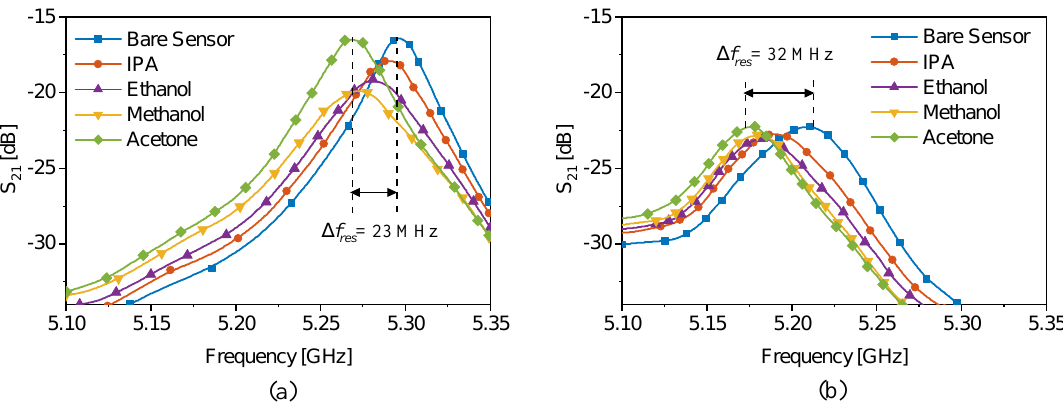
Figure 16. Measured transmission response for both sensors using ( a ) external channel and ( b ) embedded channel filled with IPA, ethanol, methanol and acetone. Reprinted with permission from Ref.